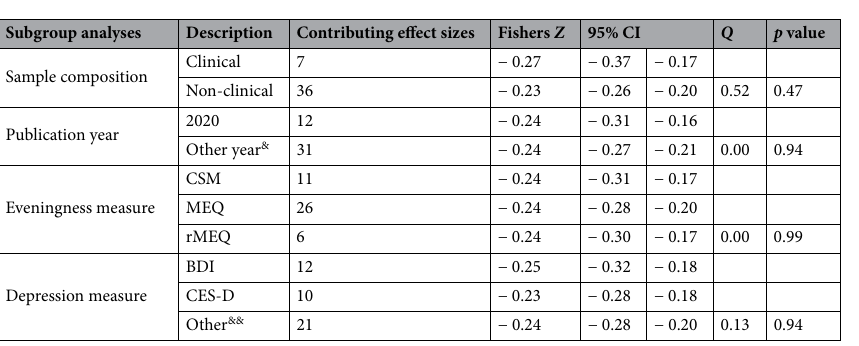
Table 2. Subgroup analysis. Other year & = publication year other than 2020; Other && = any depression measure other than BDI or CES-D (see text for details). Q-test for between study heterogeneity, p value for subgroup differences.